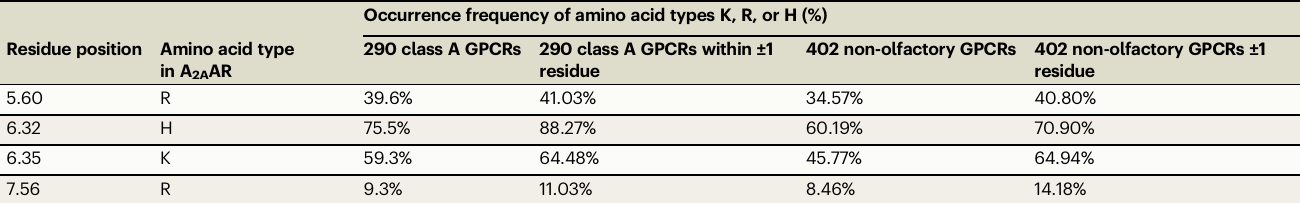
Table 1 | Sequence conservation of positively charged amino acids on the intracellular ends of helices V, VI, and